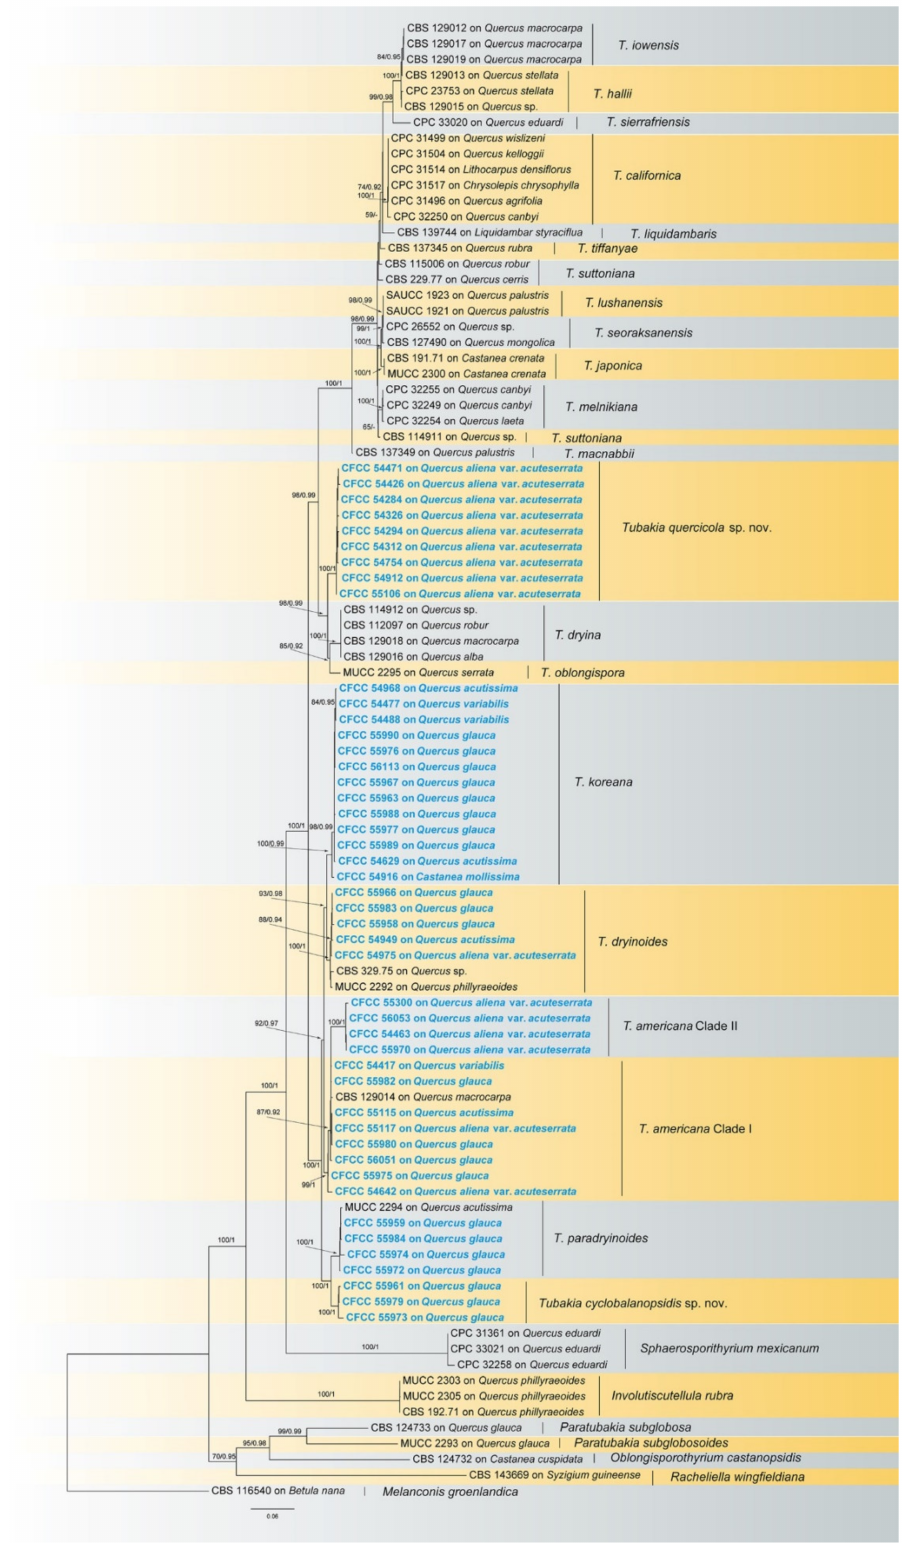
Figure 1. A phylogram of Tubakia resulting from a maximum likelihood analysis based on a combined matrix of ITS, tef1 and tub2 . Numbers above the branches indicate ML bootstrap values (left, ML BS ≥ 50%) and Bayesian Posterior Probabilities (right, BPP ≥ 0.9). The tree is rooted with Melanconis groenlandica (CBS 116540). Isolates from the present study are marked in blue and bold